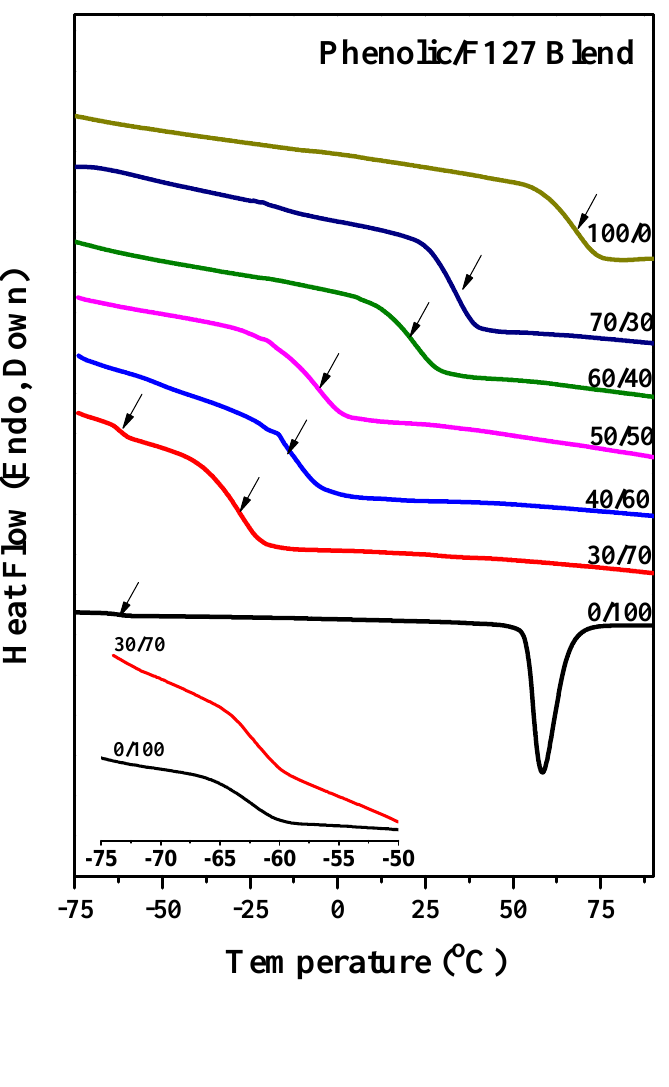
Figure 1. Differential scanning calorimetry (DSC) thermograms of phenolic/F127 blends at various